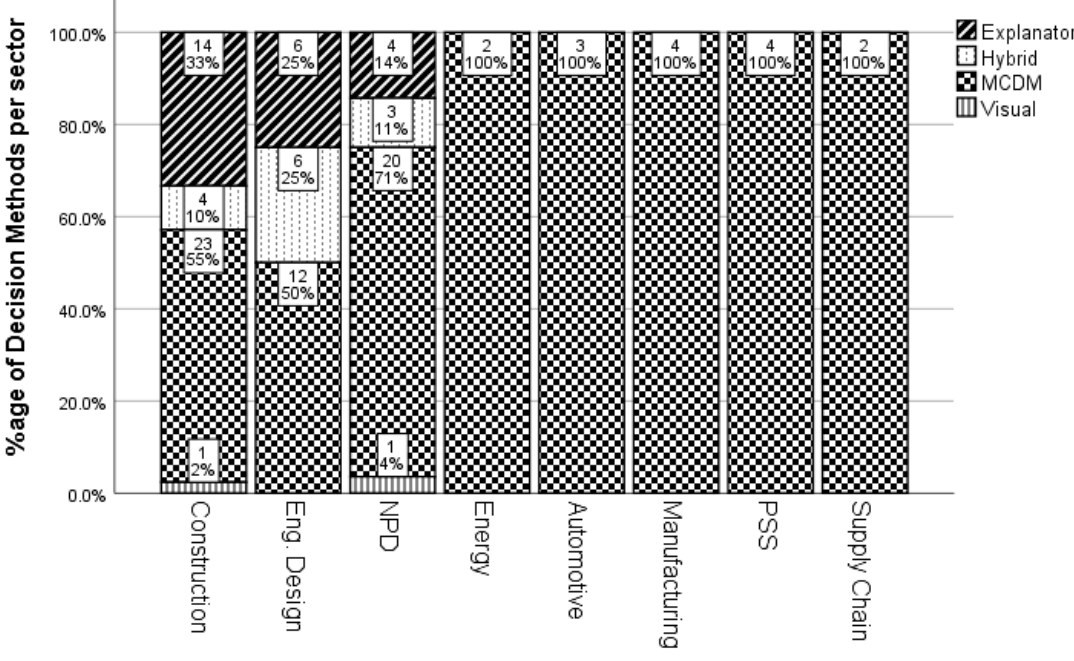
Figure 4. Sector distribution of decision methods.